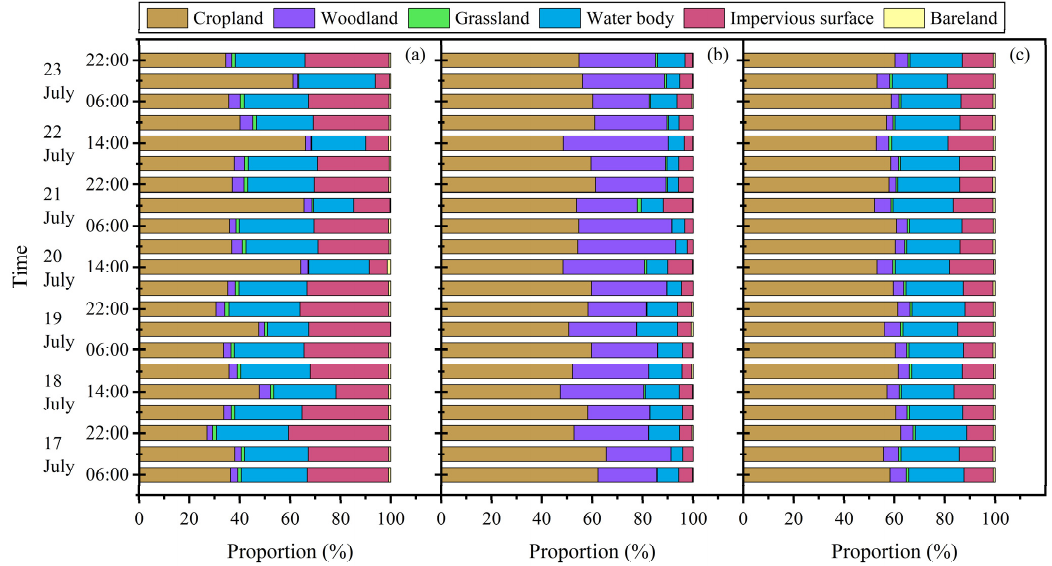
Figure 9. Proportions of land uses in the local spatial patterns. ( a ) HH cluster; ( b ) LL cluster; ( c ) no significance cluster.